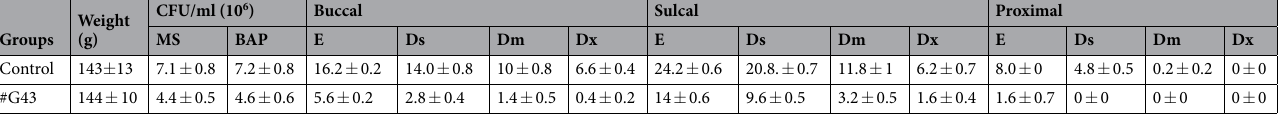
Table 1. Effects of the lead compound on bacterial colonization and mean caries scores in vivo . Two groups of 6 rats infected with S. mutans UA159, and treated with or without #G43. Caries Scores: Buccal: Enamel (E); p < 0.001: Dentinal slight (Ds); p < 0.001: Dentinal moderate (Dm); p < 0.001: Dentinal extensive